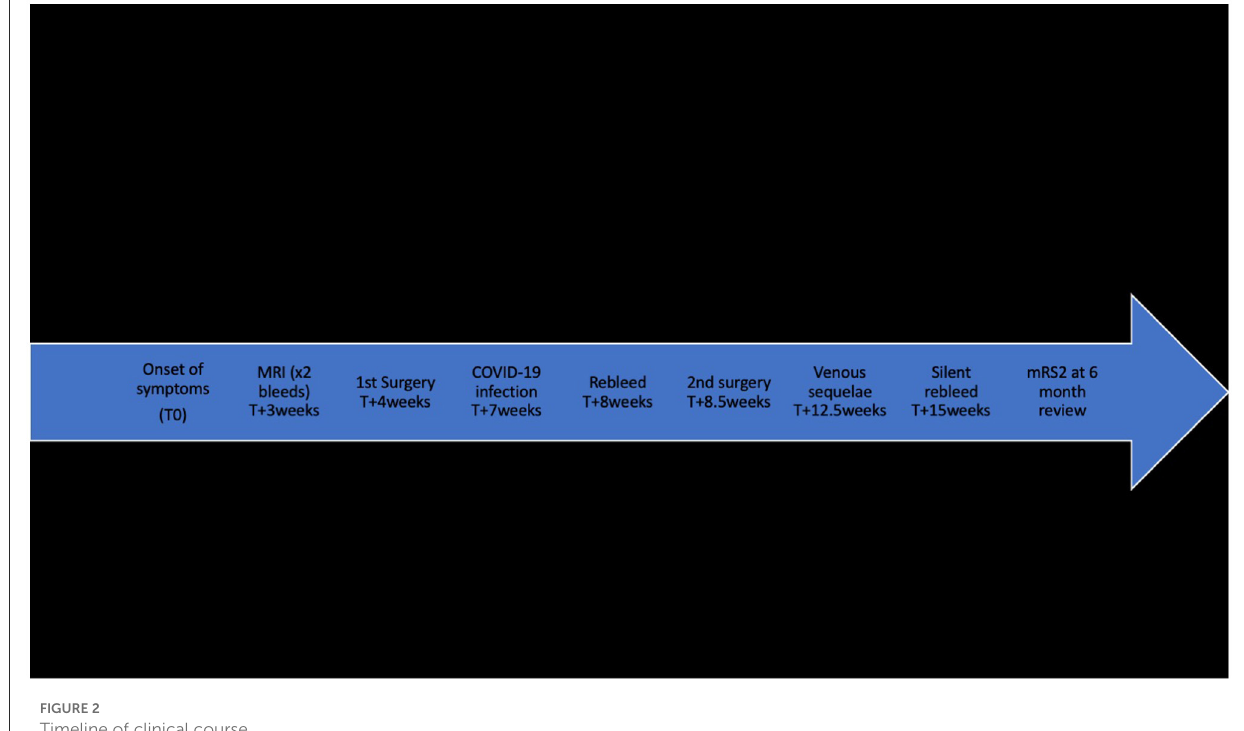
FIGURE2 Timeline of clinical